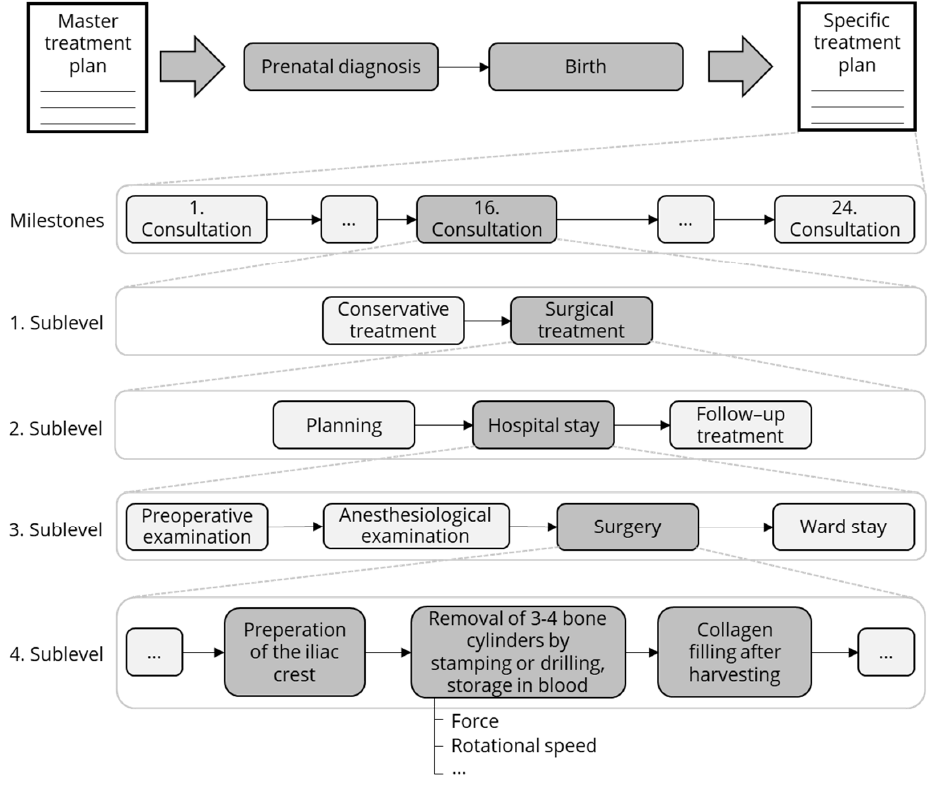
Figure 3. Process chart of bone harvesting.